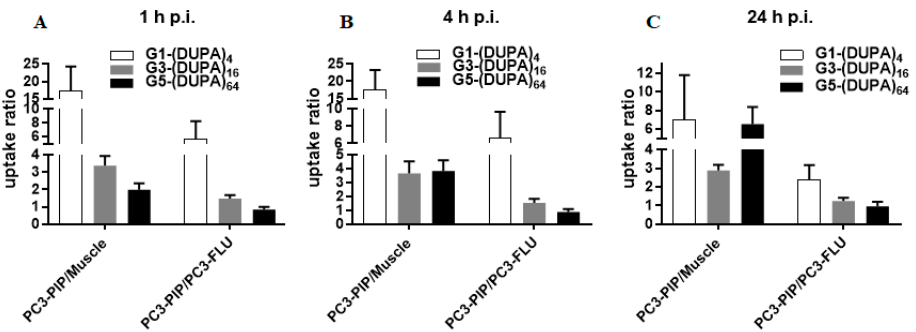
Figure 4. PC3-PIP to muscle and PC3-PIP to PC3-FLU uptake ratios of the 64 Cu-labeled dendrimers in SCID mice bearing PC3-PIP cells on the left shoulder and PC3-FLU cells on the right shoulder at 1 h p.i. ( A ), 4 h p.i. ( B ), and 24 h p.i. ( C ). ( n = 3 for G1-(DUPA) 4 and G5-(DUPA) 64 ; n = 4 for G3-(DUPA) 16 ).